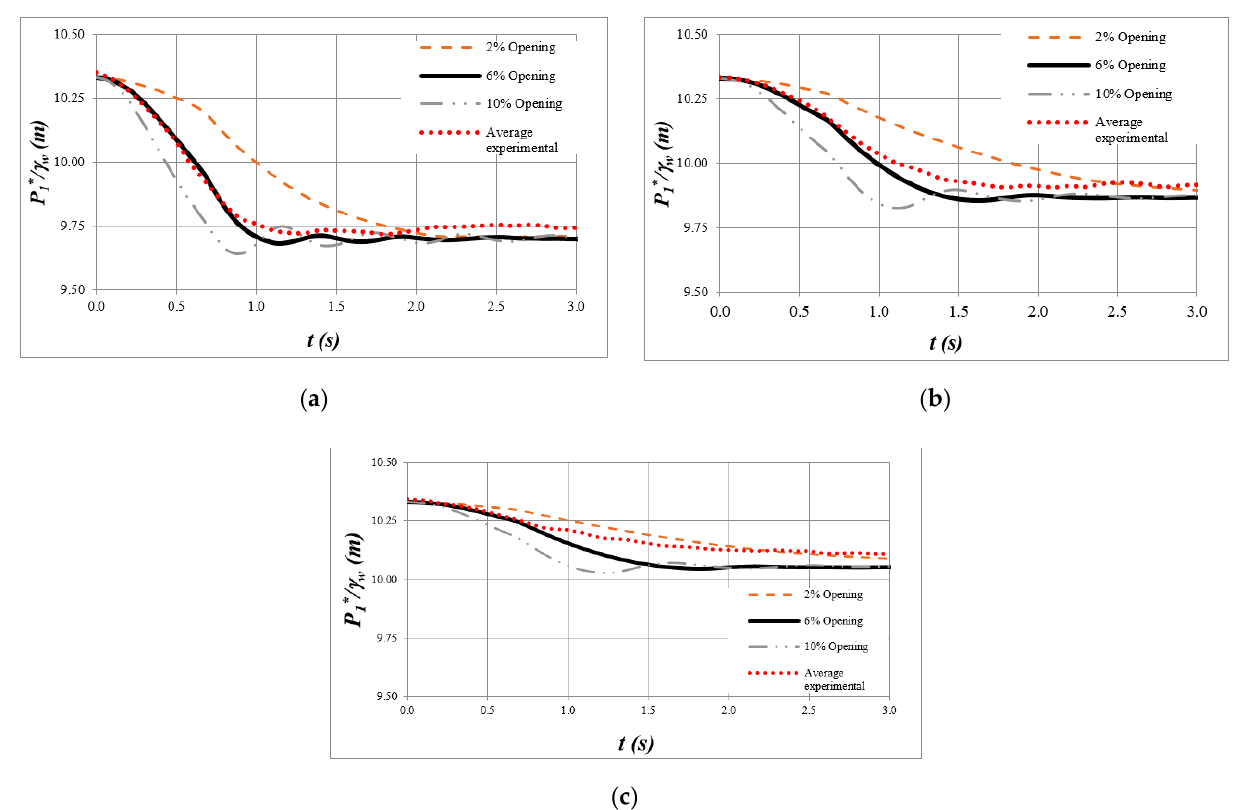
Figure 9. Sensitivity analysis of cases of partial valve opening: ( a ) case A1; ( b ) case A2; ( c ) case A3.